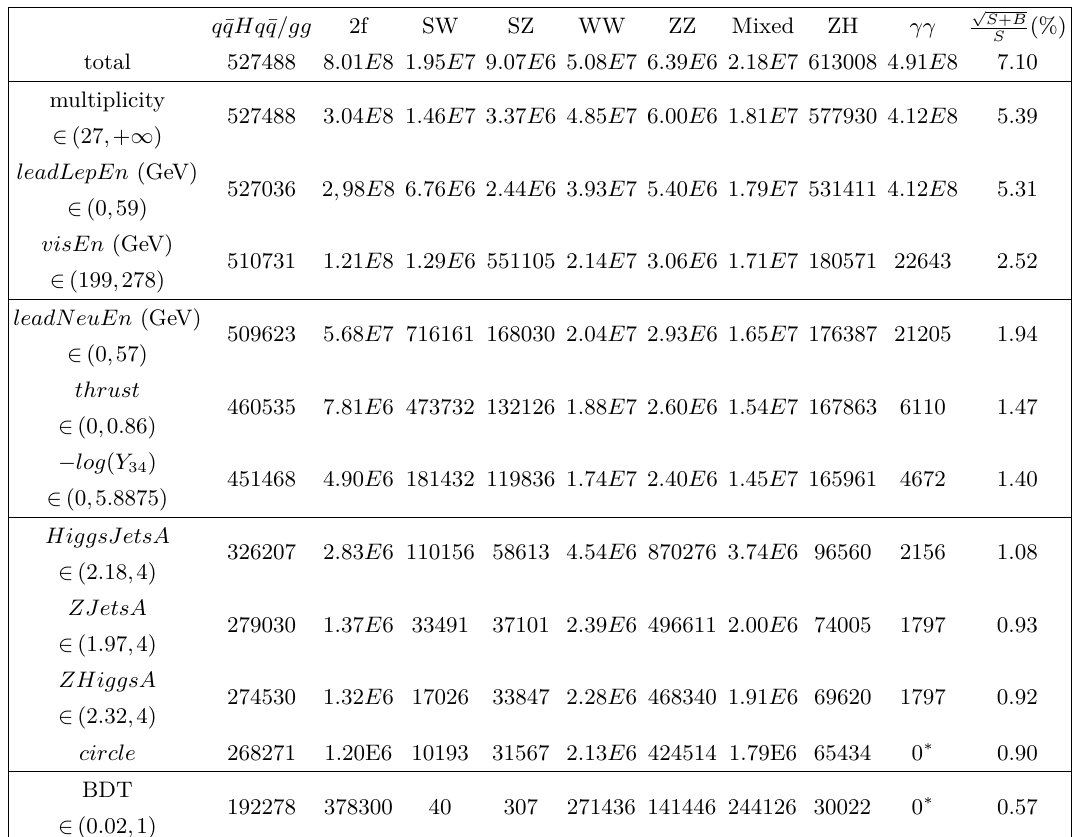
Table 2 . The event selection of q ¯ qH ( H → q ¯ q/gg ) is based on the integrated luminosity of 5 . 6 ab − 1 . The γγ is the abbreviation for γγ → hadrons process. The symbol 0 ∗ represents that the number of γγ → hadrons events is less than 3 . 09 / 0 . 0028 at a confidence level of 95% according to Feldman- Cousins approach in the case of observing a zero event, where 3.09 is quoted from ref. [22] and 0.0028 is the scaling factor of the γγ → hadrons